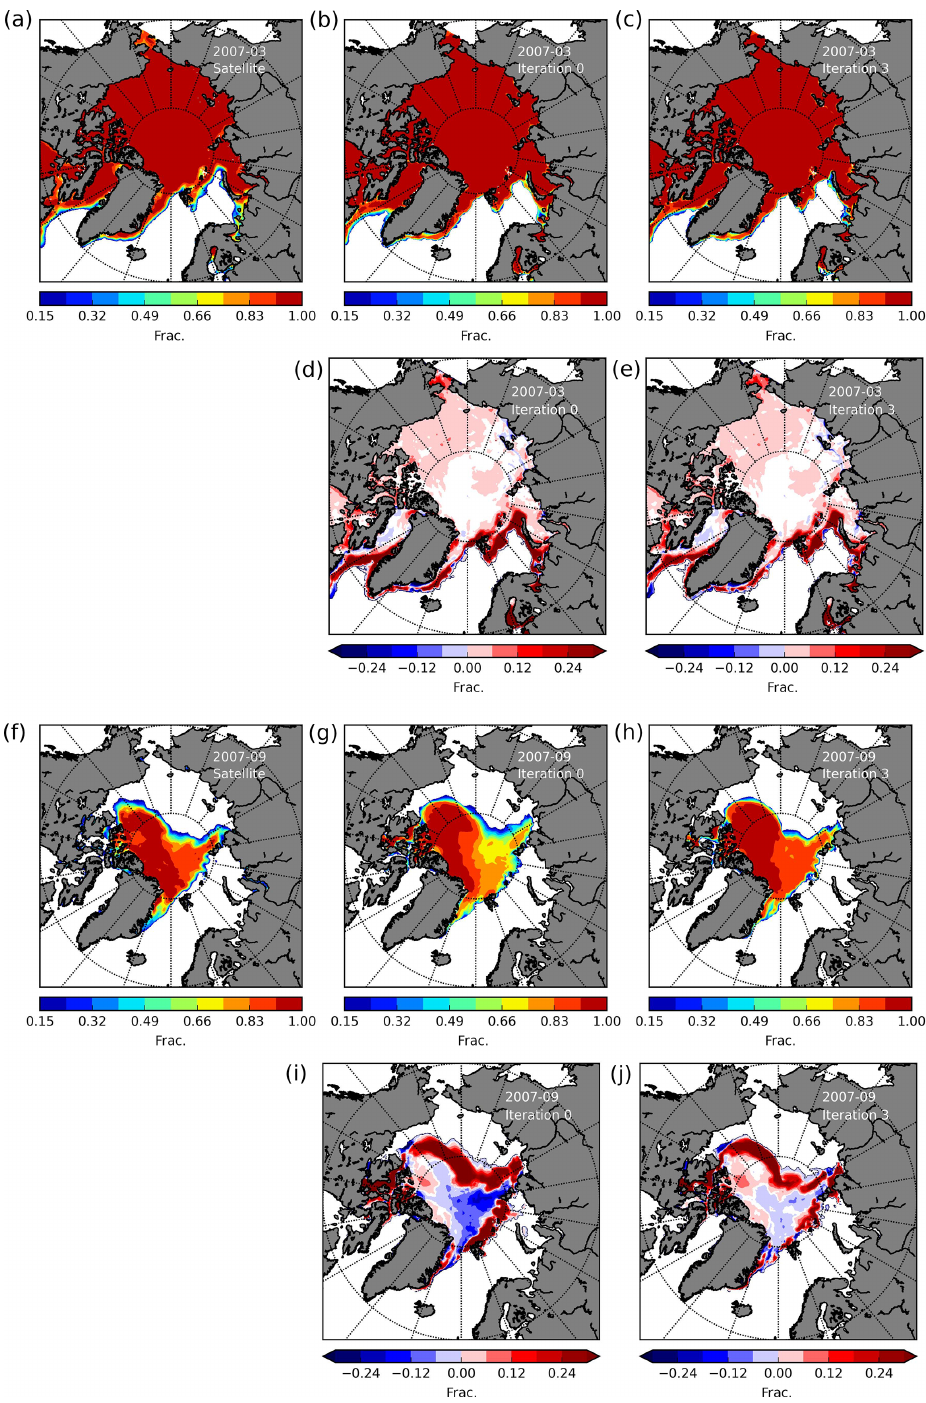
Figure 4. Same as Fig. 3, but for the year 2007 (the year of the overall minimum sea ice).